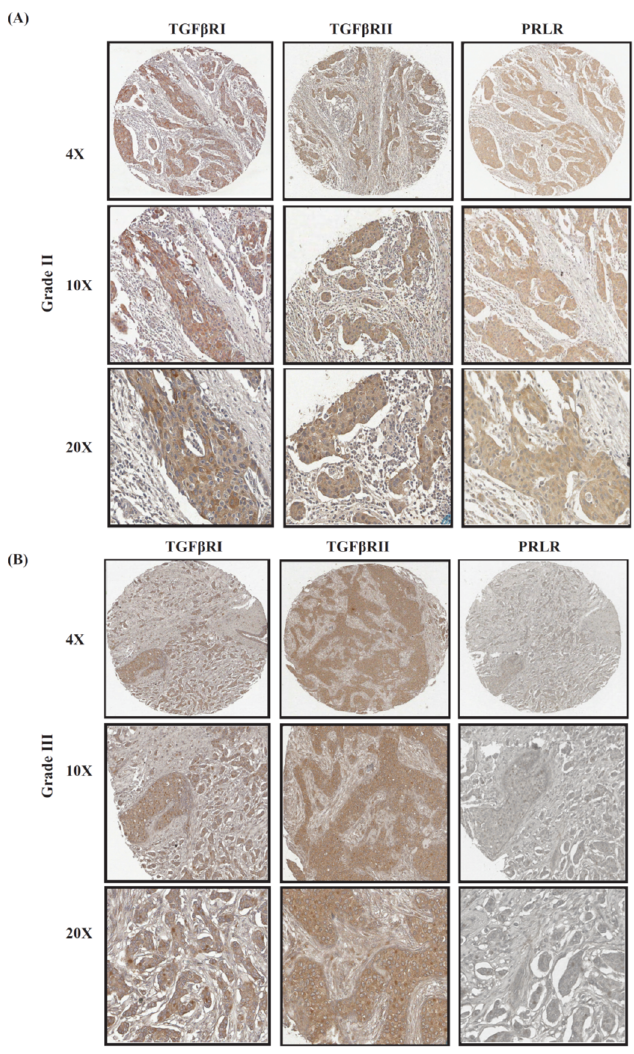
Figure 2. Representative images of co-expression of PRLR with both TGFβ receptors in ( A ) grade II tumors compared to ( B ) grade III tumors.